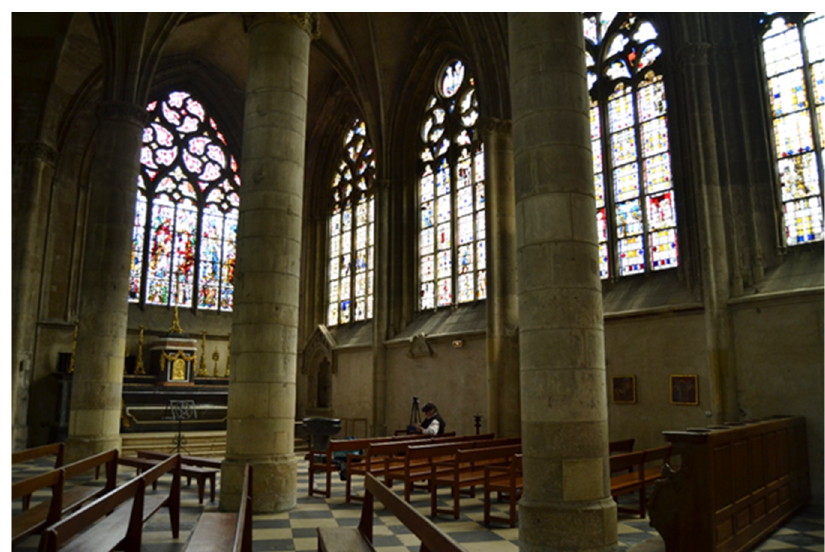
Figure 5. Saint-Lô, Church of Notre-Dame, Saint-Thomas chapel towards the southeast. The Saint Thomas window appears above the altar in the chapel’s eastern wall. © author.